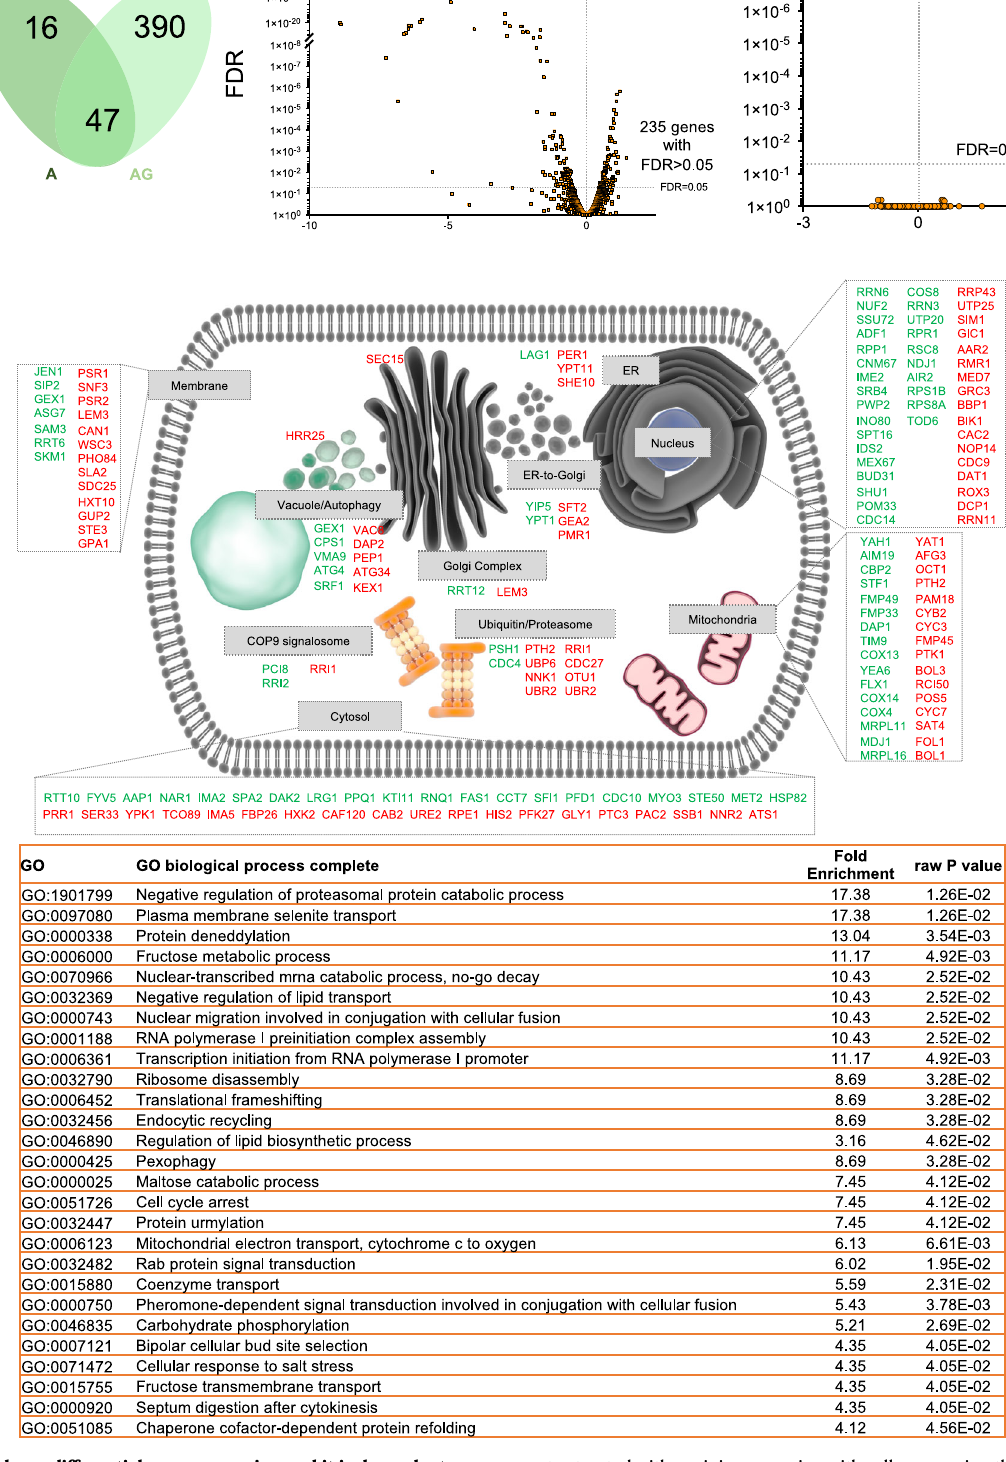
vector treated with genipin comparing with cells expressing the empty vector. d Illustration (built with the free library of science and medical illustration from somersault18:24) of the distribution of the annotated genes differentially expres- sed in α Syn-GFP expressing cells treated with genipin comparing with α Syn-GFP expressing cells (Supplementary table 4). e Gene Ontology (GO) analysis of Biolo- gicalProcesses enriched upon the incubation of α Syn-GFPexpressing cellswith